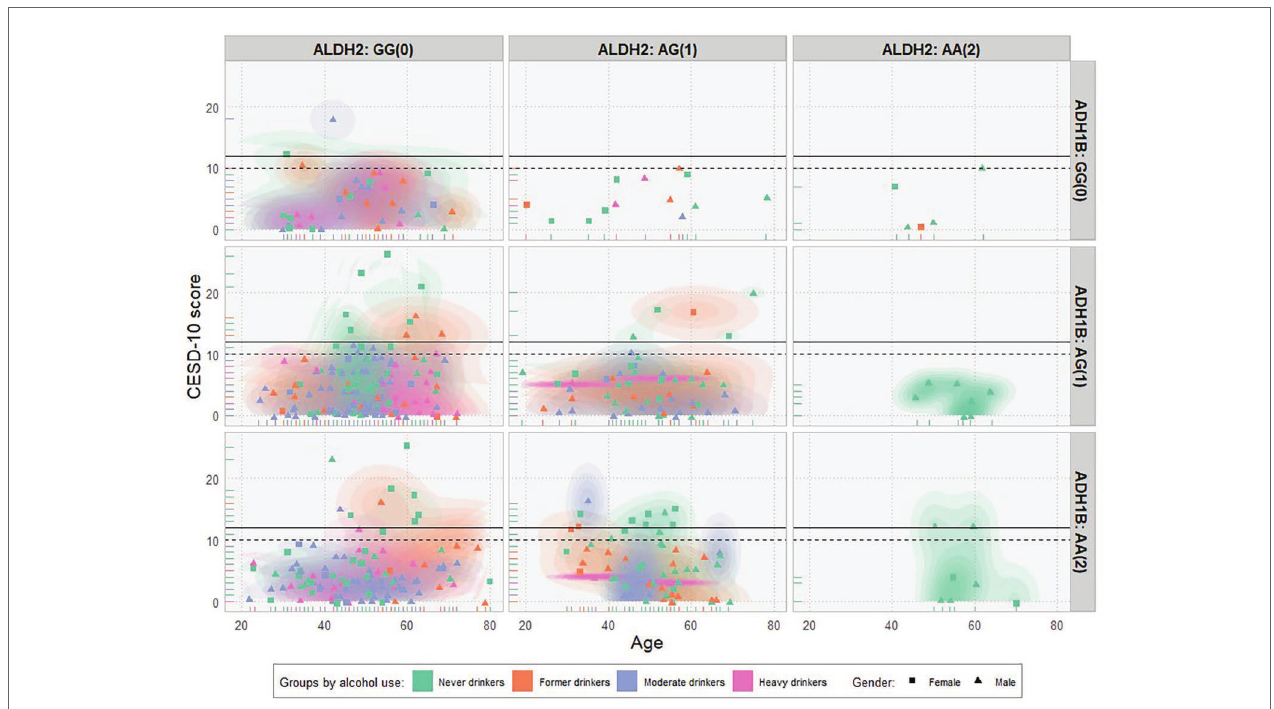
FIGURE 1 | Scatter plot of CESD-10 scores over age by gender, genotypes, and groups of alcohol use ( N = 476). CESD-10 scores over age were plotted by different combinations of ALDH2 rs671 (horizontal) and ADH1B rs1229984 (vertical) genotypes (with the number of effect alleles in parenthesis). Each dot represents a single subject. The solid and dashed black horizontal lines denote for cut-off scores of 12 (optimal) and 10 for the depression, respectively. Different genders (female/male) and groups of alcohol use (never drinkers/former drinkers/moderate drinkers/heavy drinkers) were represented by distinct shapes and colors, respectively.